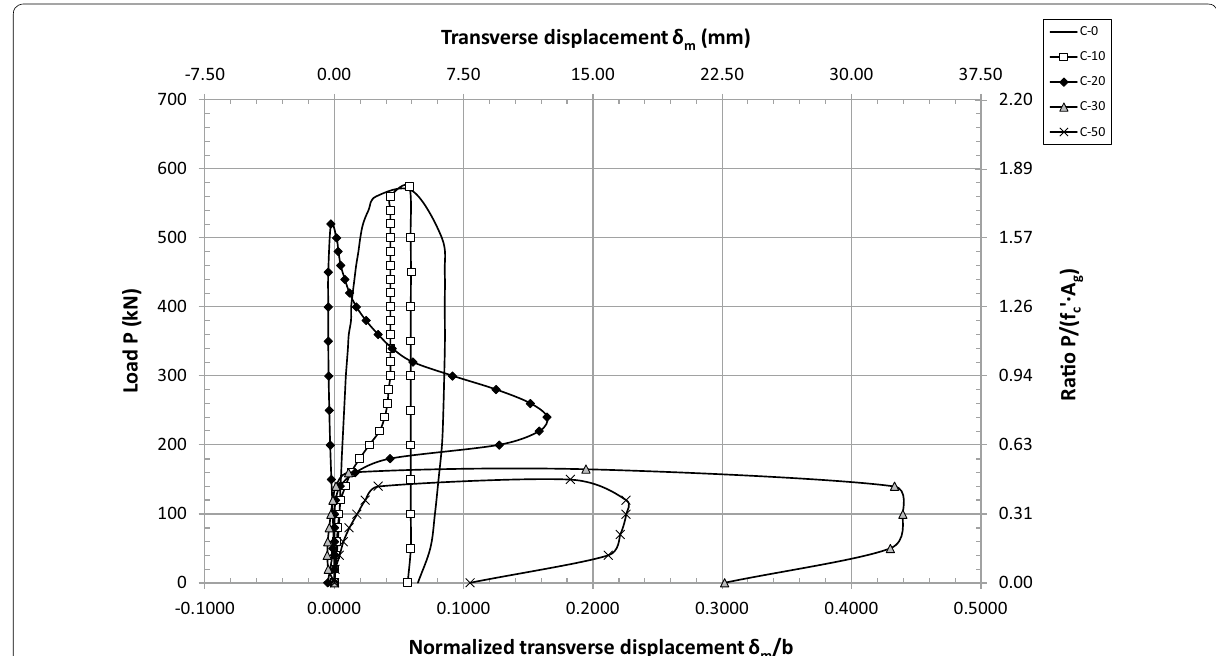
Fig. 8 Variation of compressive load relative to transverse deformation at the mid-height of element.